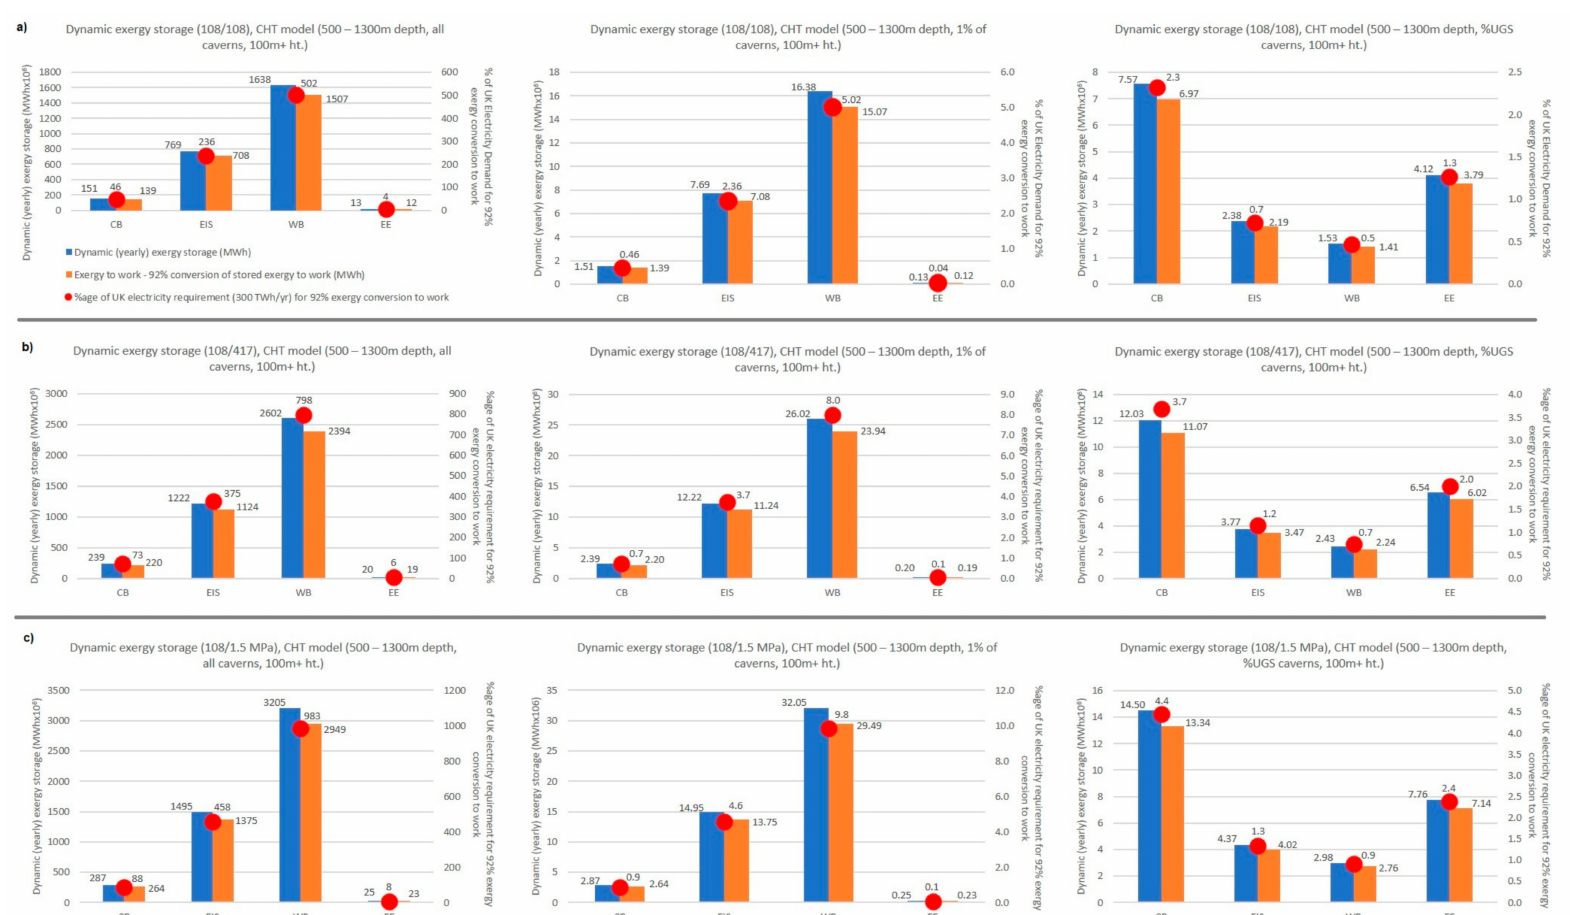
Figure 5. Plots of dynamic exergy storage and exergy to work estimates for the preferred CHT model, over the depth range 500–1300 m and cavern heights 100 m+ considered for CAES. Parts ( a – c ) show graphs for differing injection/withdrawal rates (108/108 kg/s and 108/417 kg/s) or fill and pressure reduction rates (108 kg/s/1.5 MPa/h) for all potentially available caverns, 1% of available caverns and estimates based upon the number of UGS caverns in the basins. Additionally shown, by basin, the percentage of UK electricity demand for 92% of stored exergy to work. Key common to all, see Figure